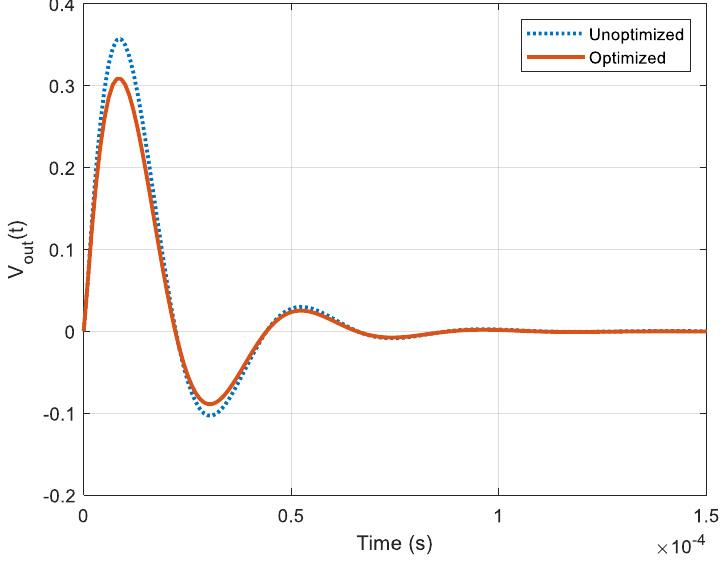
Figure 8. Disturbance rejection performance offered by digital compensators.